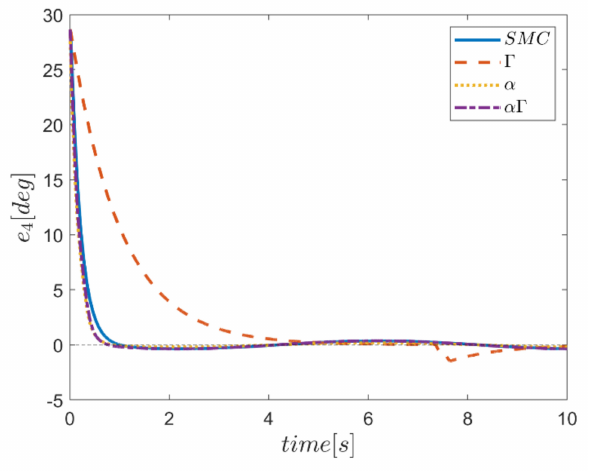
Figure 43. Tracking error in the Φ channel.